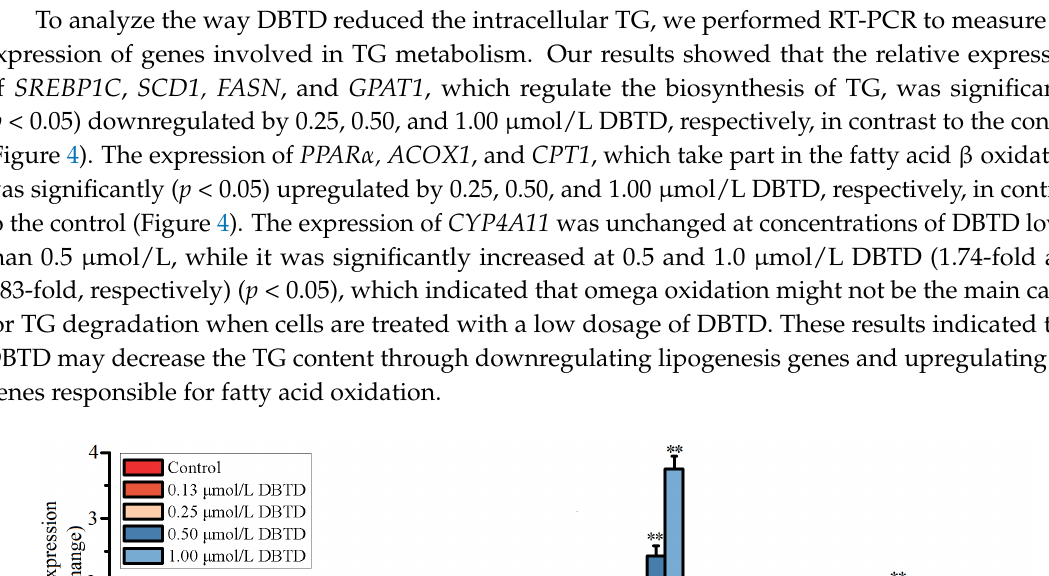
0.25, 0.50, and 1.00 μmol/L DBTD for 24 h in contrast to the control group (Con). The expressions of